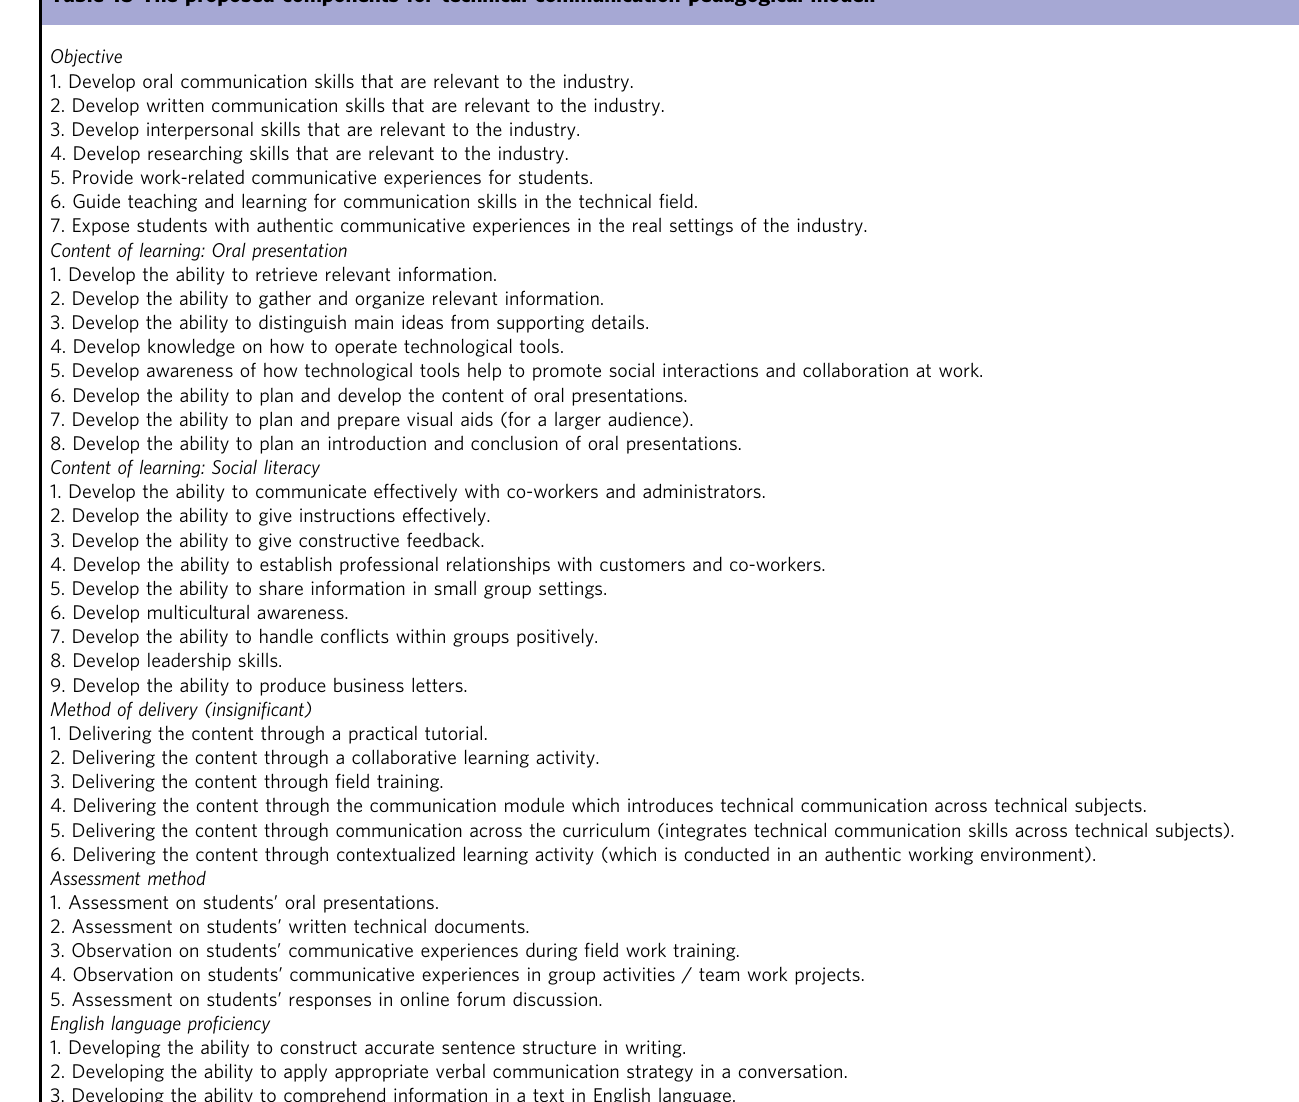
Table 18 The proposed components for technical communication pedagogical